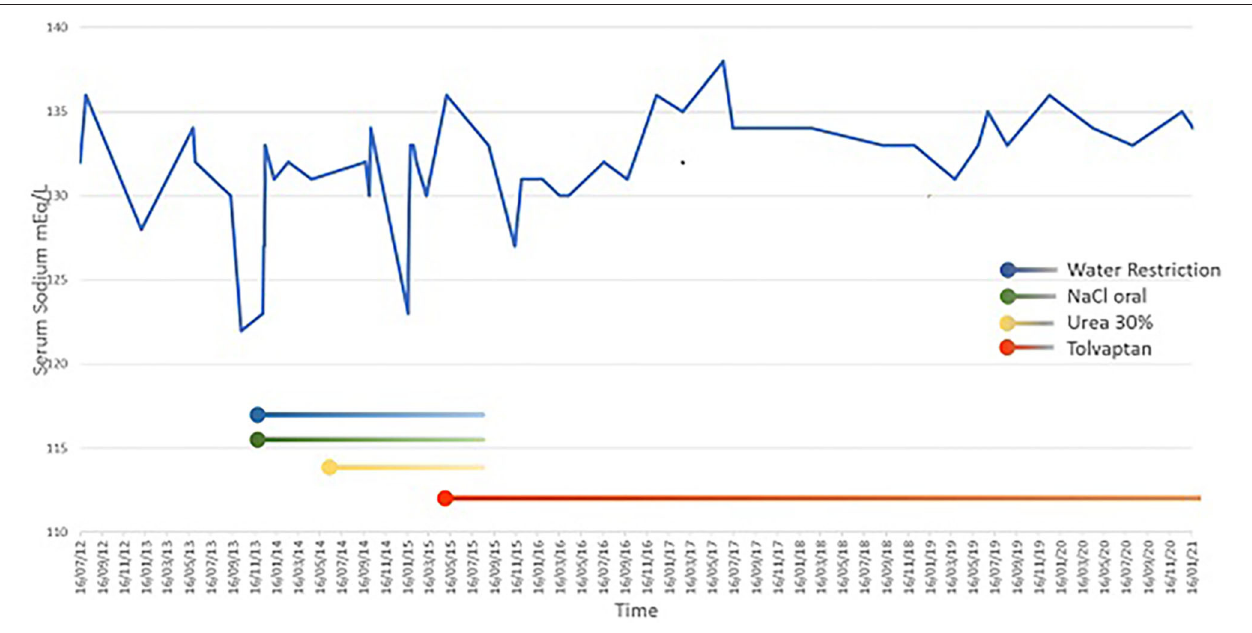
FIGURE 2 | Serum sodium values during different